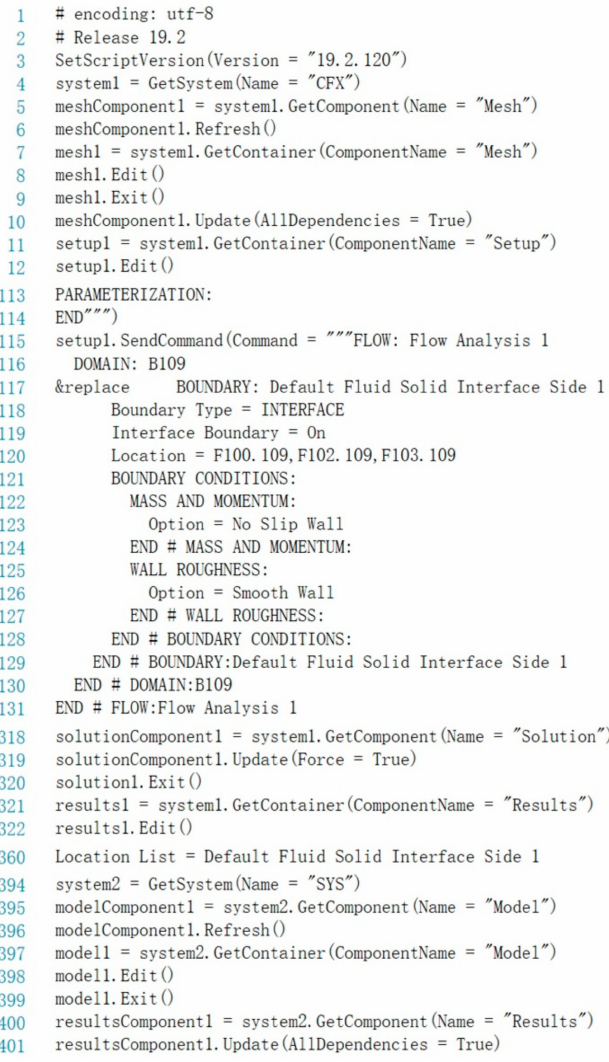
Figure 6. Partial code of the scripting file in the intelligent control